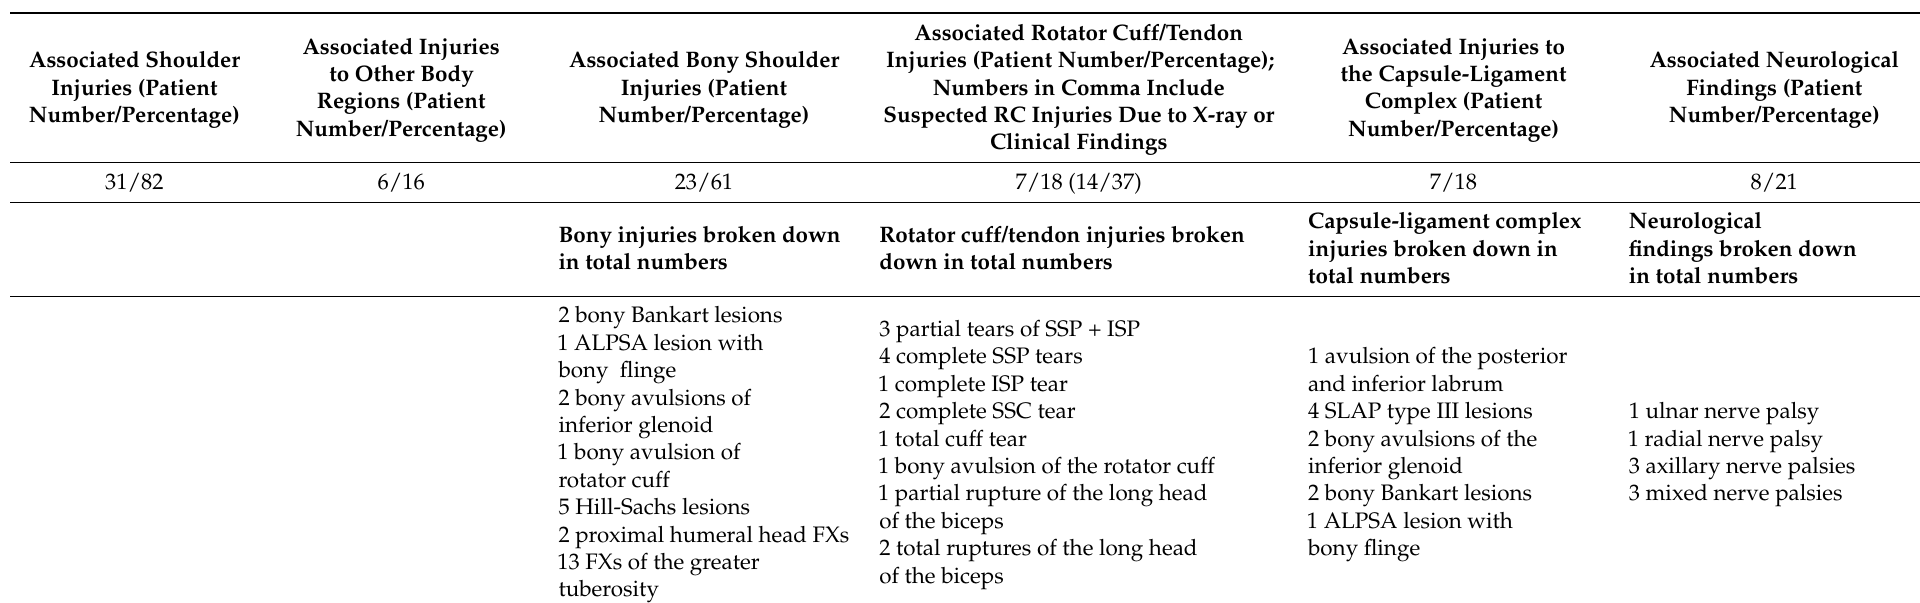
Table 3. Summary of the key results regarding associated